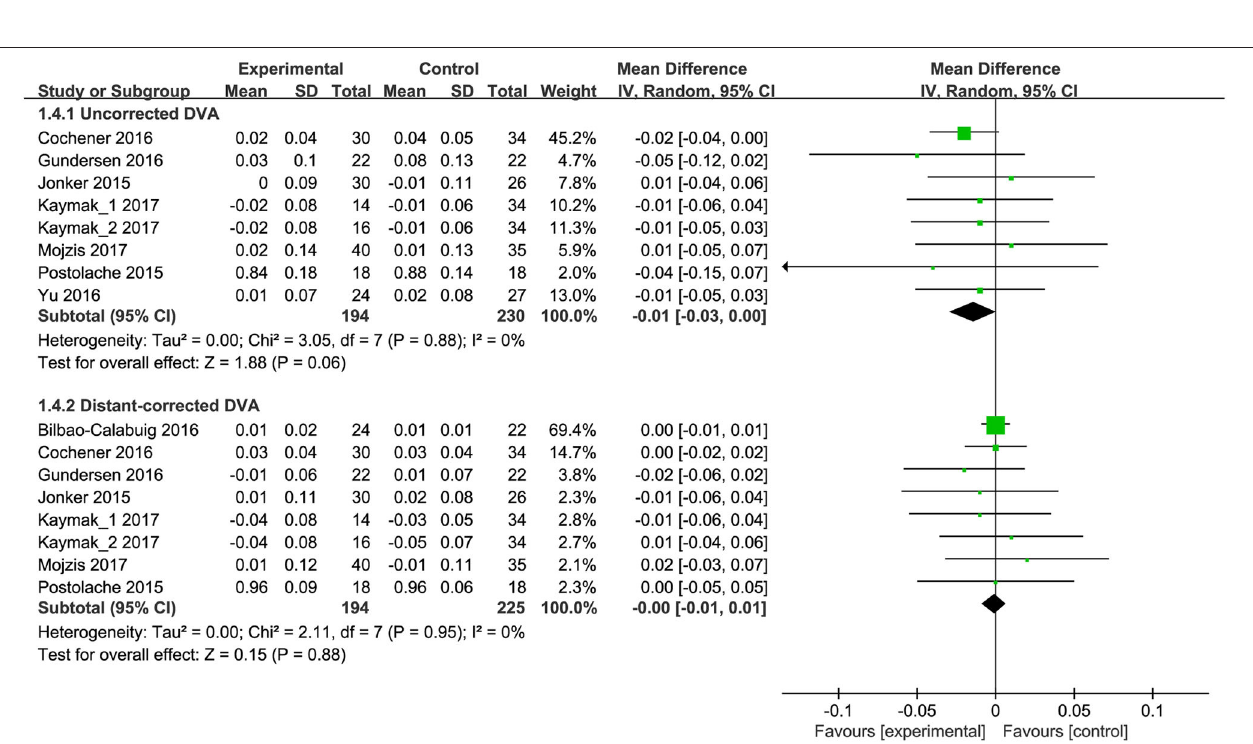
Frontiers in Medicine |